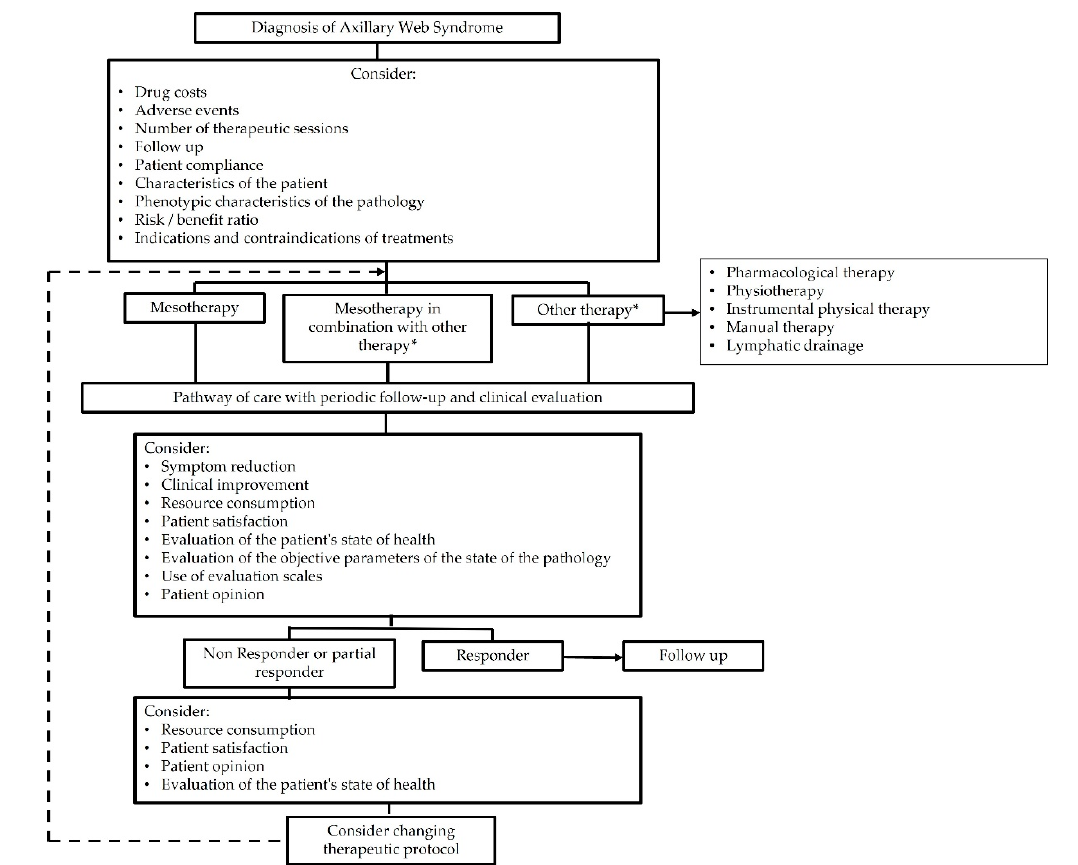
Figure 1. Algorithm for the treatment of pain in mesotherapy (intradermal therapy—IDT).